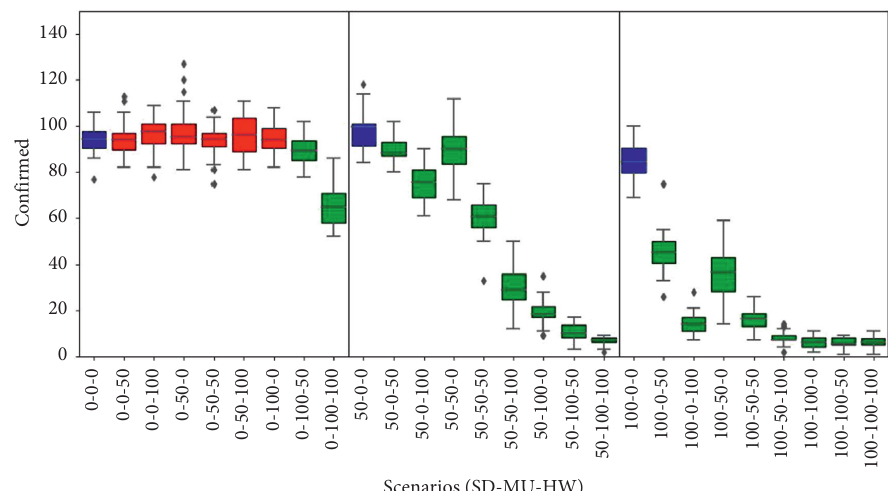
Figure 6: Confirmed cases results. Box plots represent average and standard deviation of the cumulative count of only those cases reported as diagnosed. Scenarios are labelled according to the willingness of agents to adhere to personal health habits such as social distance, mask user, or hands washer (SD%, MU%, and HW%). Baseline scenarios were defined varying the proportion of social distancers in the population assuming no agents adopt using masks or washing hands. In each panel, the baseline scenario is coloured blue (left, 0%-0%-0%; middle, 50%-0%-0%; right, 100%-0%-0%). Scenarios with statistical significant difference compared to their corresponding panel baseline (blue) are coloured green ( p value < 0 : 05); otherwise, they are coloured red.